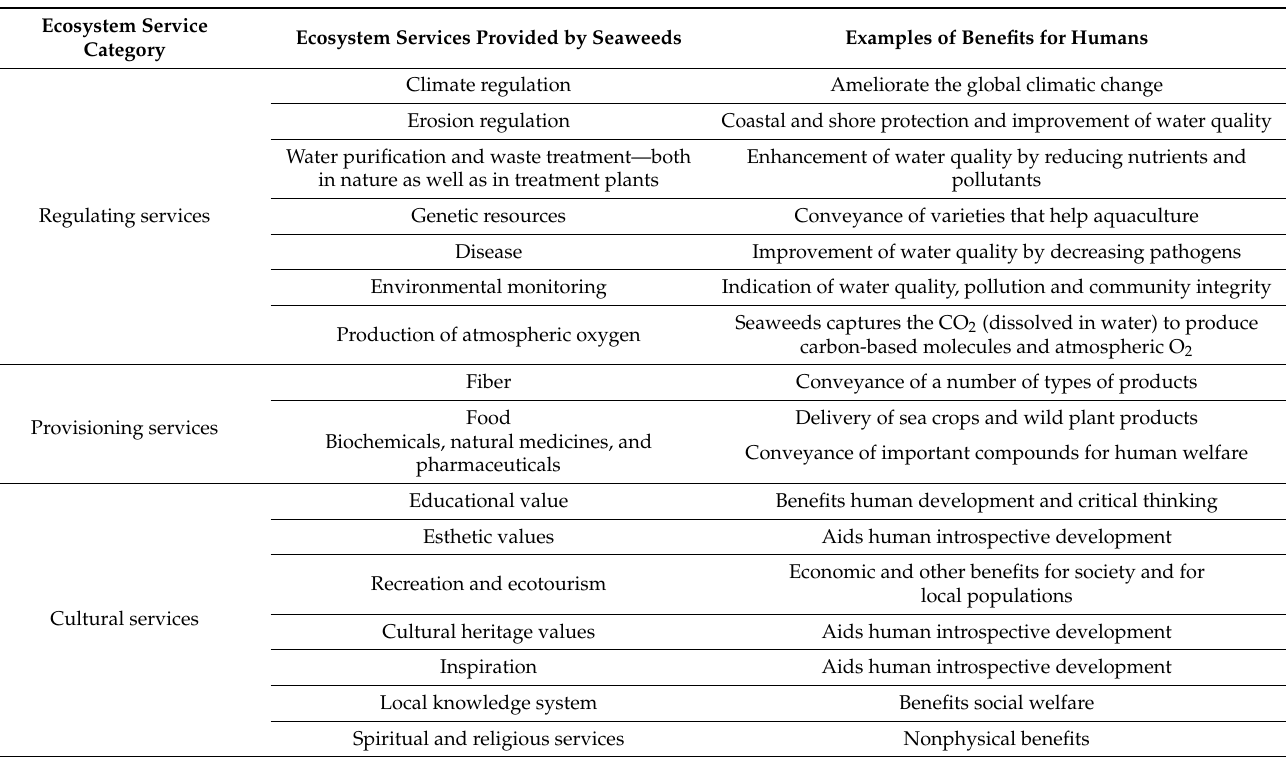
Table 2. Ecosystem services categories and ecosystem services provided by seaweeds (according to Reid [23] and CICES [25,26]), and examples of benefits for